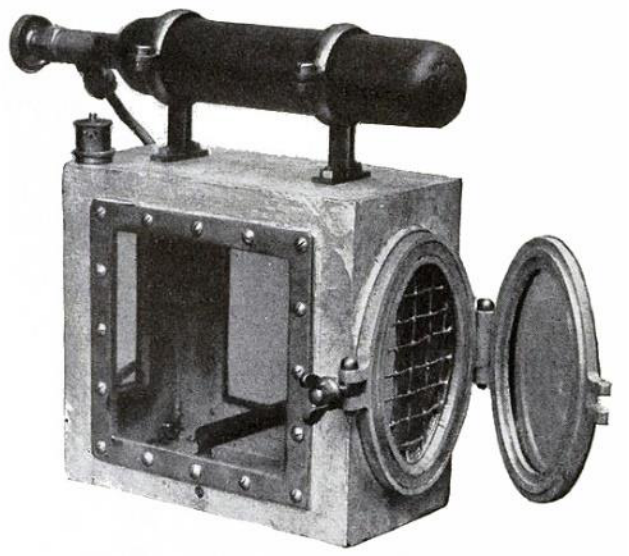
Figure 1. Canaries as toxic gas detectors [4].